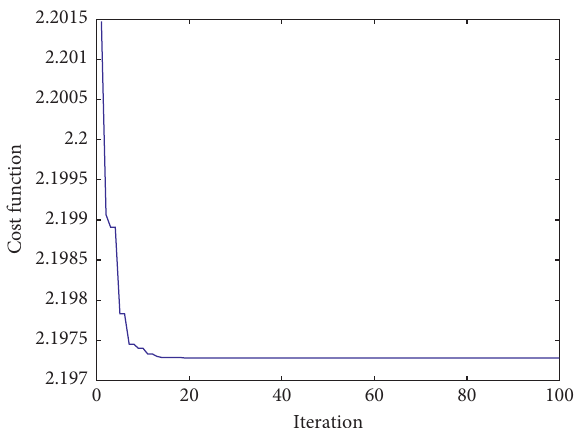
Figure 6: Convergence of the cost function for the numerical model updating with the PSO algorithm.